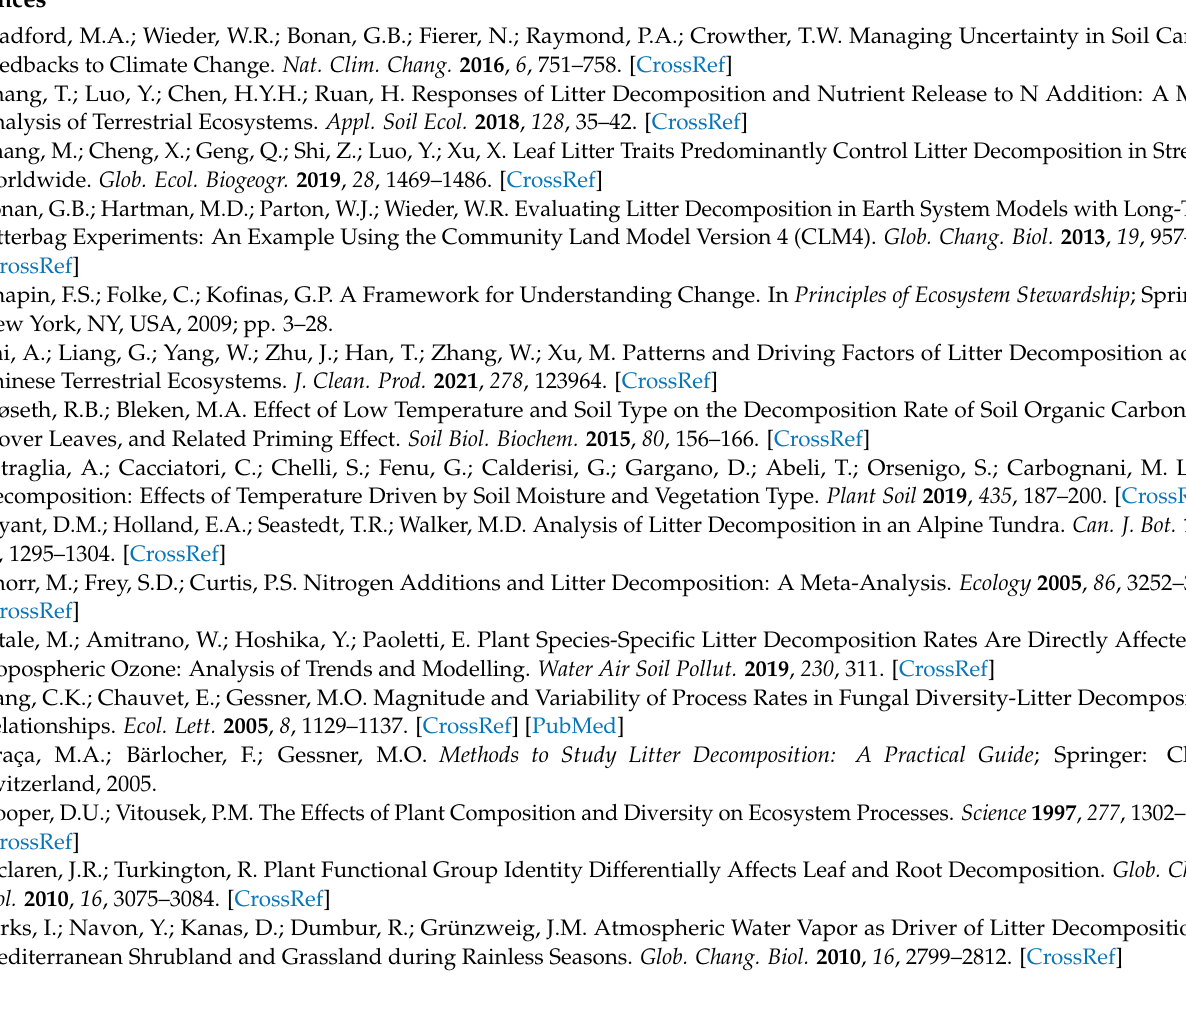
Laziale Forest. Figure S1: Palo Laziale daily NDVI; Table S2: M1 and M2 simulation values; Figure S2: Palo Laziale leaf area